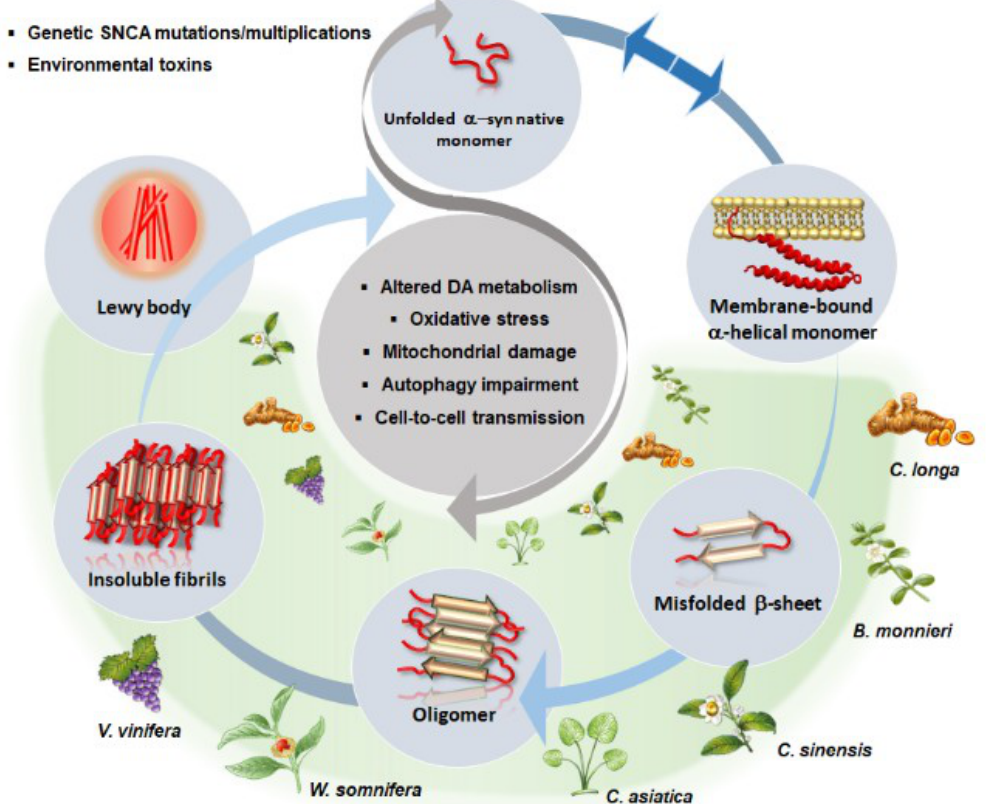
Figure 2. A schematic overview of the beneficial e ff ects of phytochemical-rich plants in α -syn aggregation dynamics (light grey circles), and related molecular mechanisms (central dark grey circle) occurring in PD. In a physiological state, a dynamic equilibrium (blue arrows) exists between α -syn natively unfolded monomers and membrane-bound α -helical monomers (secondary structure). Environmental toxins or mutations / multiplications within α -syn gene ( SNCA ) favor α -syn misfolding / overexpression and drive a pathological cascade of conversion up to insoluble fibrils and Lewy body formation. This is associated with a generalized impairment of cell homeostasis consisting of altered DA metabolism and synaptic dysfunction, oxidative stress, mitochondrial damage, autophagy impairment, and cell-to-cell spreading of misfolded and aggregated α -syn conformers. Phytochemicals found within Curcuma longa , Bacopa monnieri , Centella asiatica , Camellia sinensis , Withania somnifera and Vitis vinifera are able to reverse / prevent the pathological conversion cascade of α -syn while counteracting alterations of DA neurotransmission, oxidative stress, mitochondrial damage and autophagy impairment (green